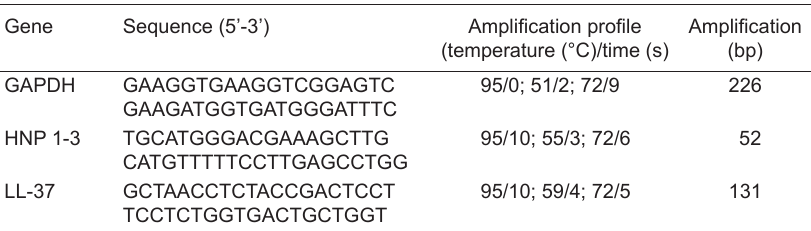
Table 1. Primer sequences for the genes, amplification profile, and amplicon length studied here.